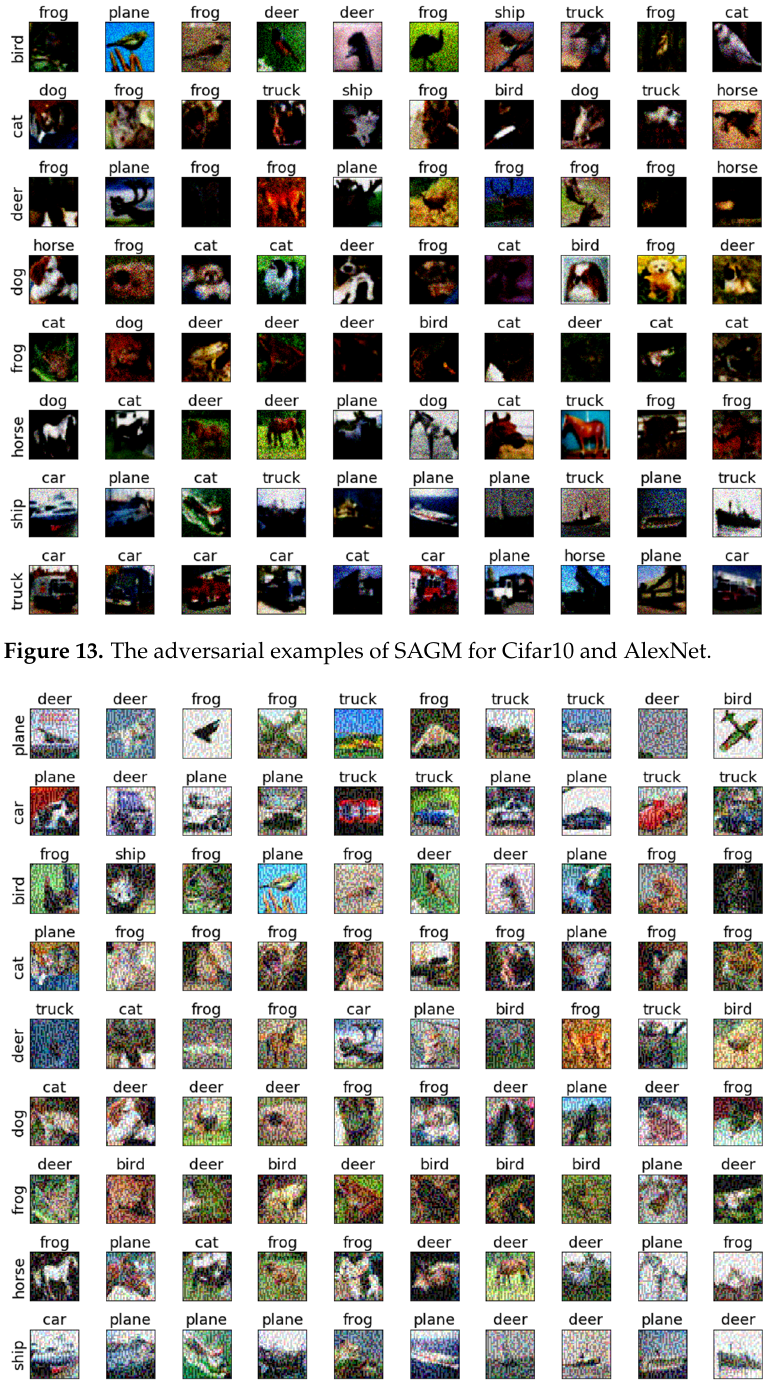
Figure 14. The adversarial examples of FGM for Cifar10 and ResNet18.